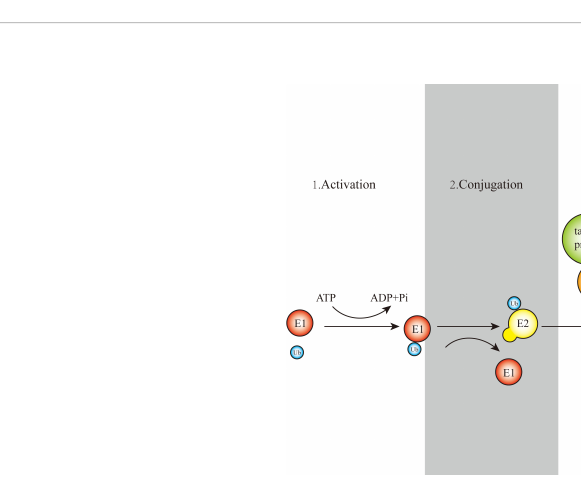
FIGURE 1 Schematic representation of the ubiquitination